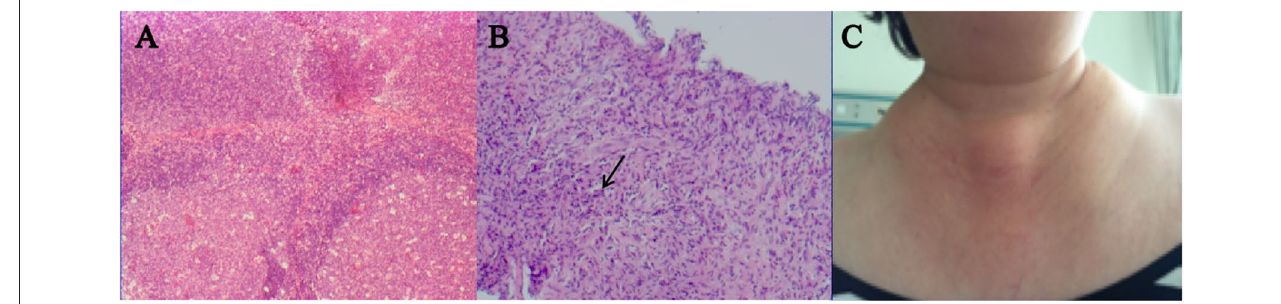
FIGURE 1 | A 55-year-old woman with clinical features and pathological manifestations showing extensive lymphoid follicle-like structures and a large infiltration of eosinophilic granulocytes (A,B) , and local mass in the neck (C) . After receiving prednisone + cyclophosphamide, her tumor became smaller but as prednisone gradually decreased, the size of her tumor slightly increased. After receiving local radiotherapy again, this patient was suffering from pulmonary infection 3 months later and finally died due to multiple organ failure.